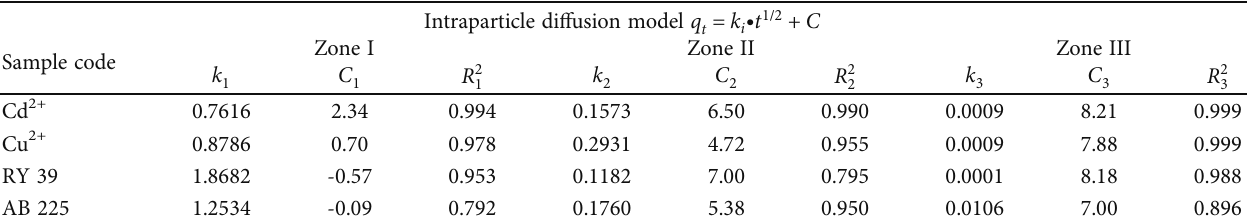
Table 4: Intraparticle di ff usion model ’ s equation and kinetic parameters for metal ions and dye adsorption onto SH-PO1.